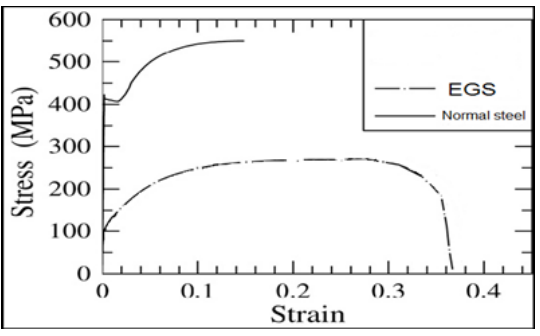
Fig. 2. Stress-strain curve for Iron EGS and constructional steel (Sabouri-Ghomi and Ziaei,